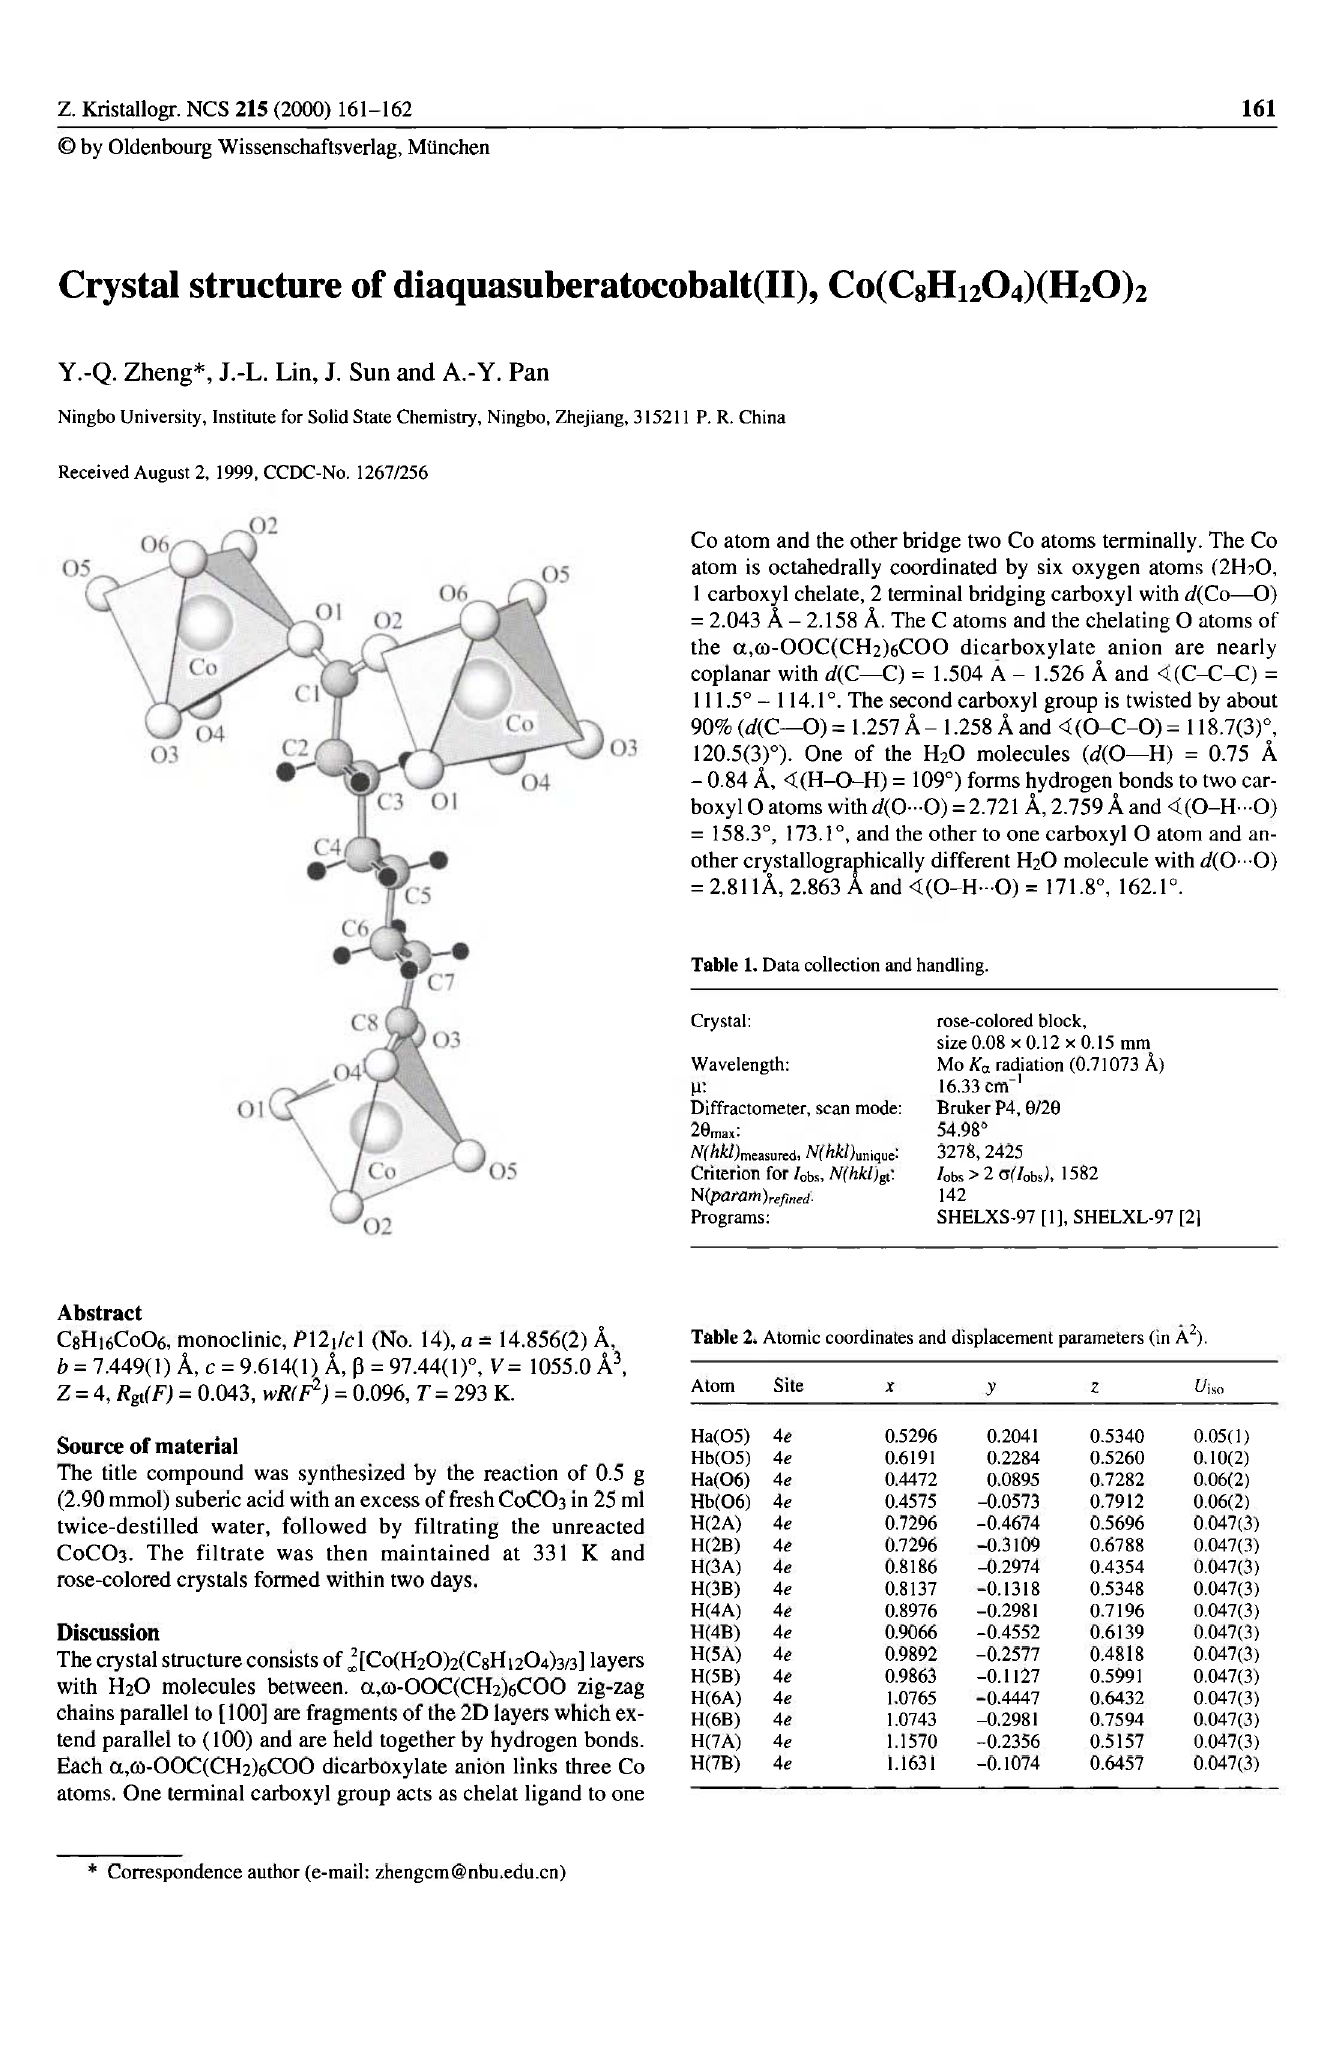
Table 1. Data collection and handling.